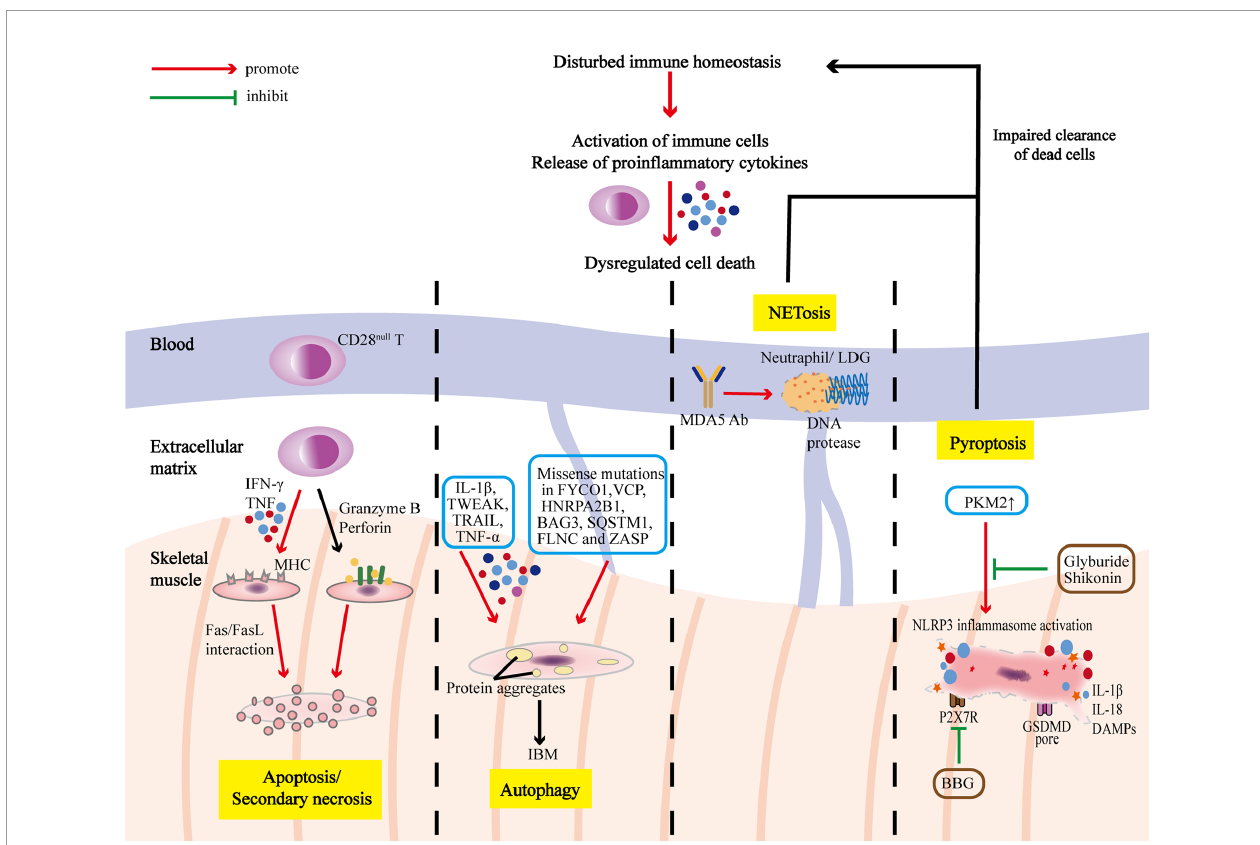
FIGURE 2 | PCD pathways in the pathogenesis and progression of IIMs. The immune homeostasis of IIM patients is disrupted with activation of immune cells and release of proin fl ammatory cytokines, which could lead to dysregulated cell death. T cells in fi ltrating in the muscles are dominated by CD28 null T cells, which are apoptosis-resistant, and could exert polarize perforin and secrete granzyme B to induce myocyte apoptosis, or release IFN- g and TNF to induce surface expression of MHC, rendering the myocytes more sensitive to cytotoxic attacks. Overmuch autophagy and impaired protein degradation result in accumulation of multiprotein aggregates, which causes myocyte degeneration characteristic of IBM. Excessive programmed necrosis (such as NETosis and pyroptosis) contribute to the release of proin fl ammatory cytokines, and DAMPs, and activation of NLRP3 in fl ammasome, further amplifying immune responses.